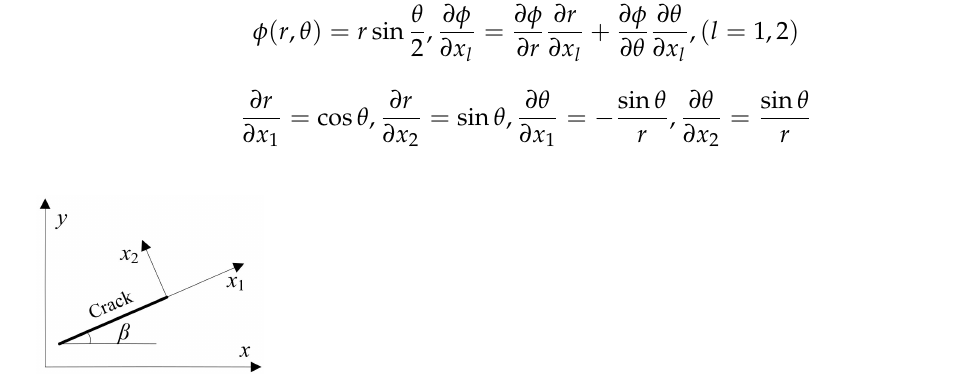
Figure 4. Global and local coordinate